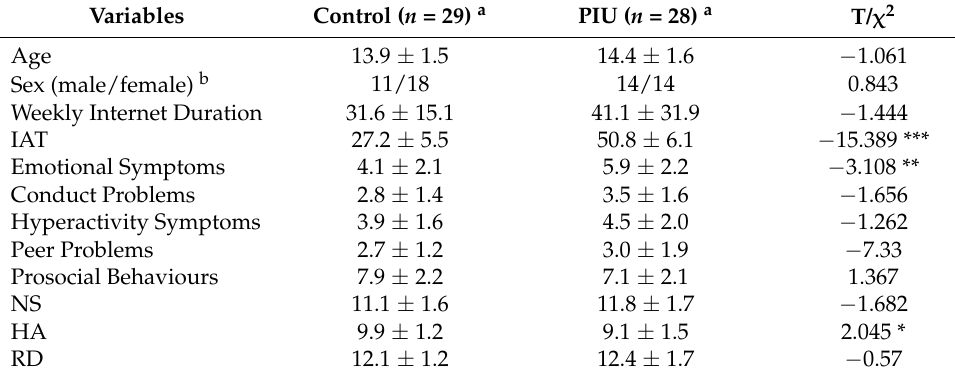
Table 1. Subjects’ demographic and descriptive scores.